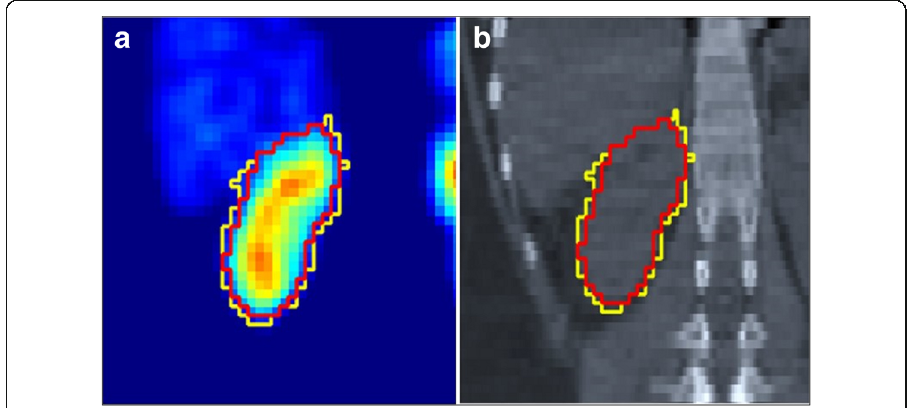
Fig. 1 An example of the right kidney segmentation based on dual iterative thresholding method in SPECT ( a ) and CT ( b ). The activity threshold was set to 25% (yellow line), and the volume threshold was equal to 36% (red